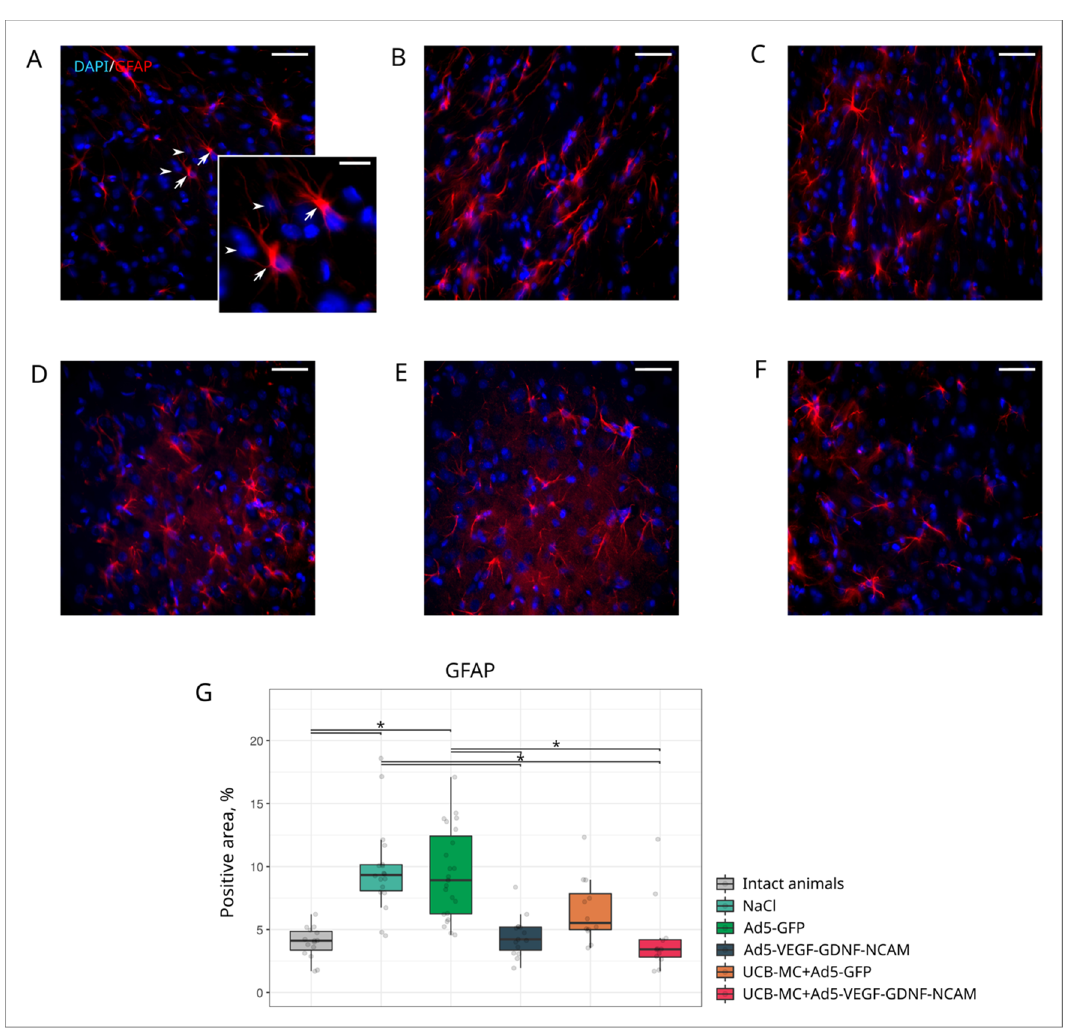
Figure 6. Immunoexpression of GFAP in the rat brain cortex, 21 days after the middle cerebral artery occlusion. Immunofluorescent staining with antibody to astrocyte specific cytoskeletal glial fibrillary acidic protein GFAP in intact ( A ), control NaCl ( B ) and Ad5-GFP ( C ), and therapeutic UCB-MC+Ad5-GFP ( D ), Ad5-VEGF-GDNF-NCAM ( E ) and UCB-MC+Ad5-VEGF-GDNF-NCAM ( F ) groups. Arrows indicate cytoplasmic localization of GFAP (red glow) in astrocytes. Arrowheads point to cell nuclei visualized using DAPI (blue glow). Scale bar in ( A – F ) = 50 µm; scale bar in the insert = 20 µm. ( G )—comparative analysis of GFAP-positive areas in experimental groups; *— p < 0.05.